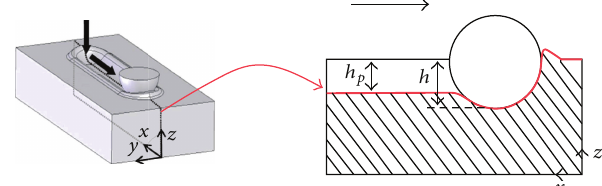
Figure 3: Representation of the zx symmetry cut